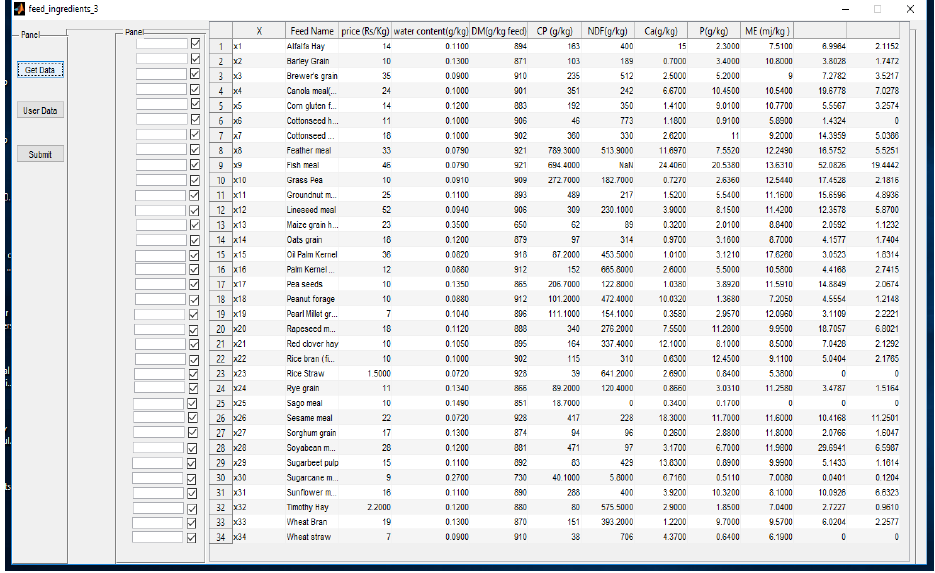
Figure 3. Feed ingredients screen